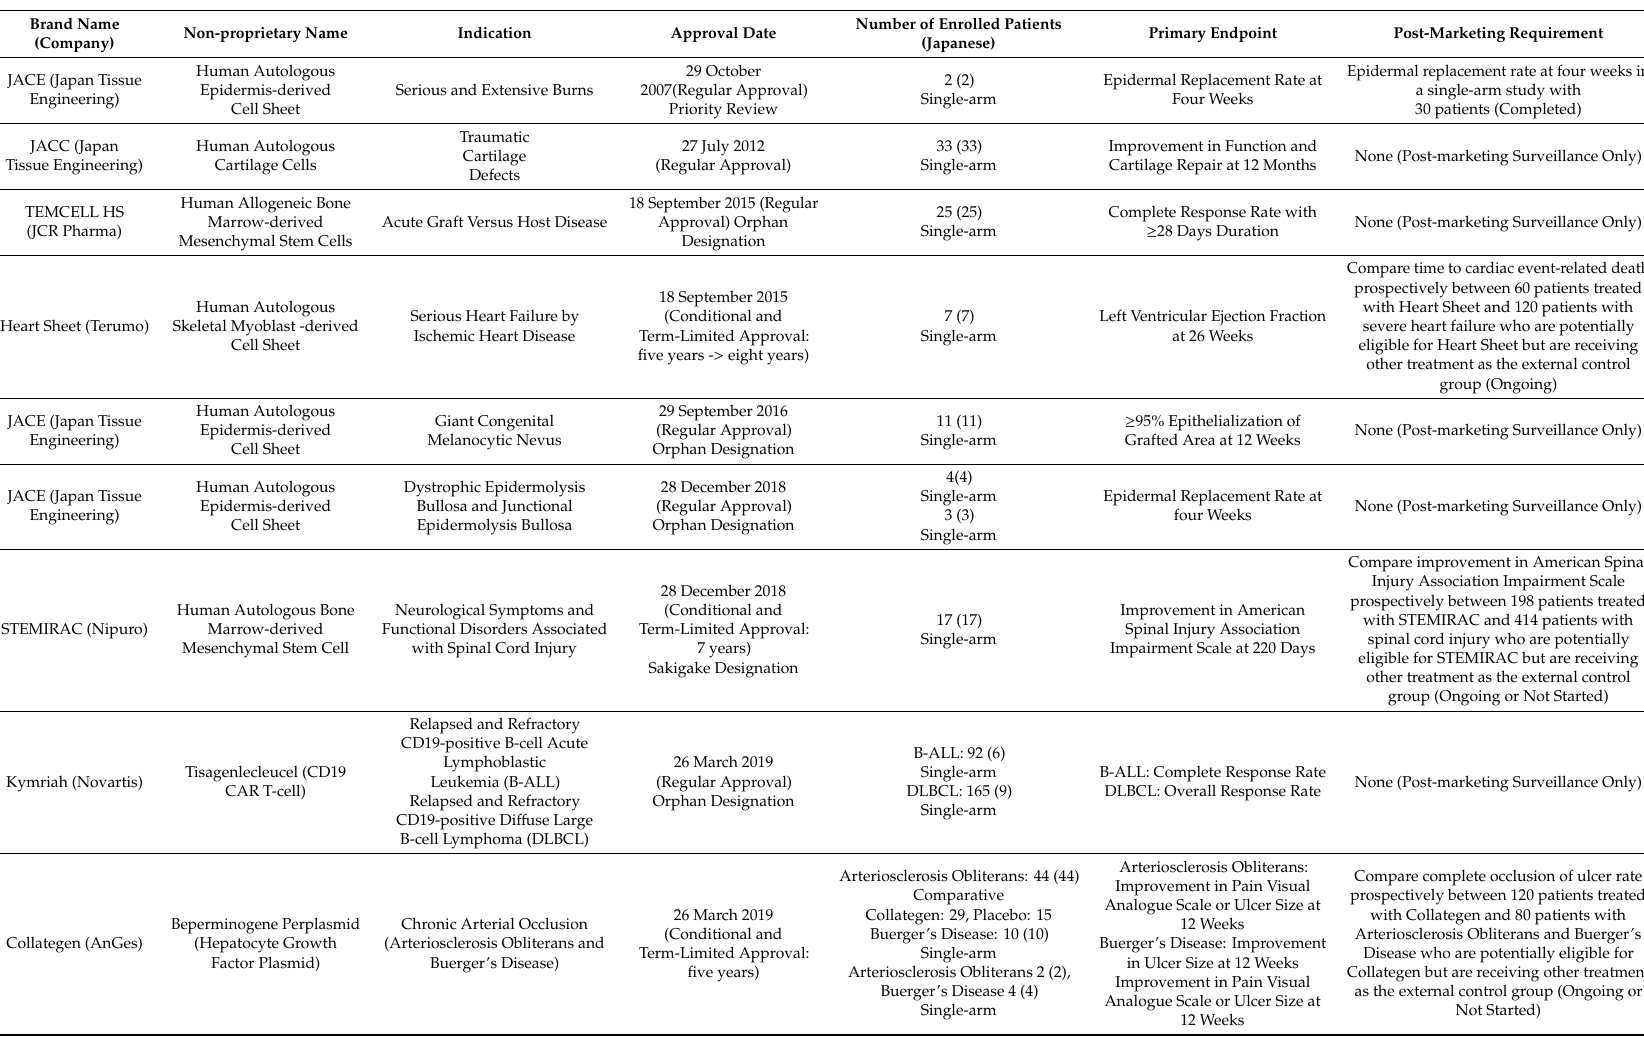
Table 5. Regenerative medical products granted approval in Japan as of 31 May